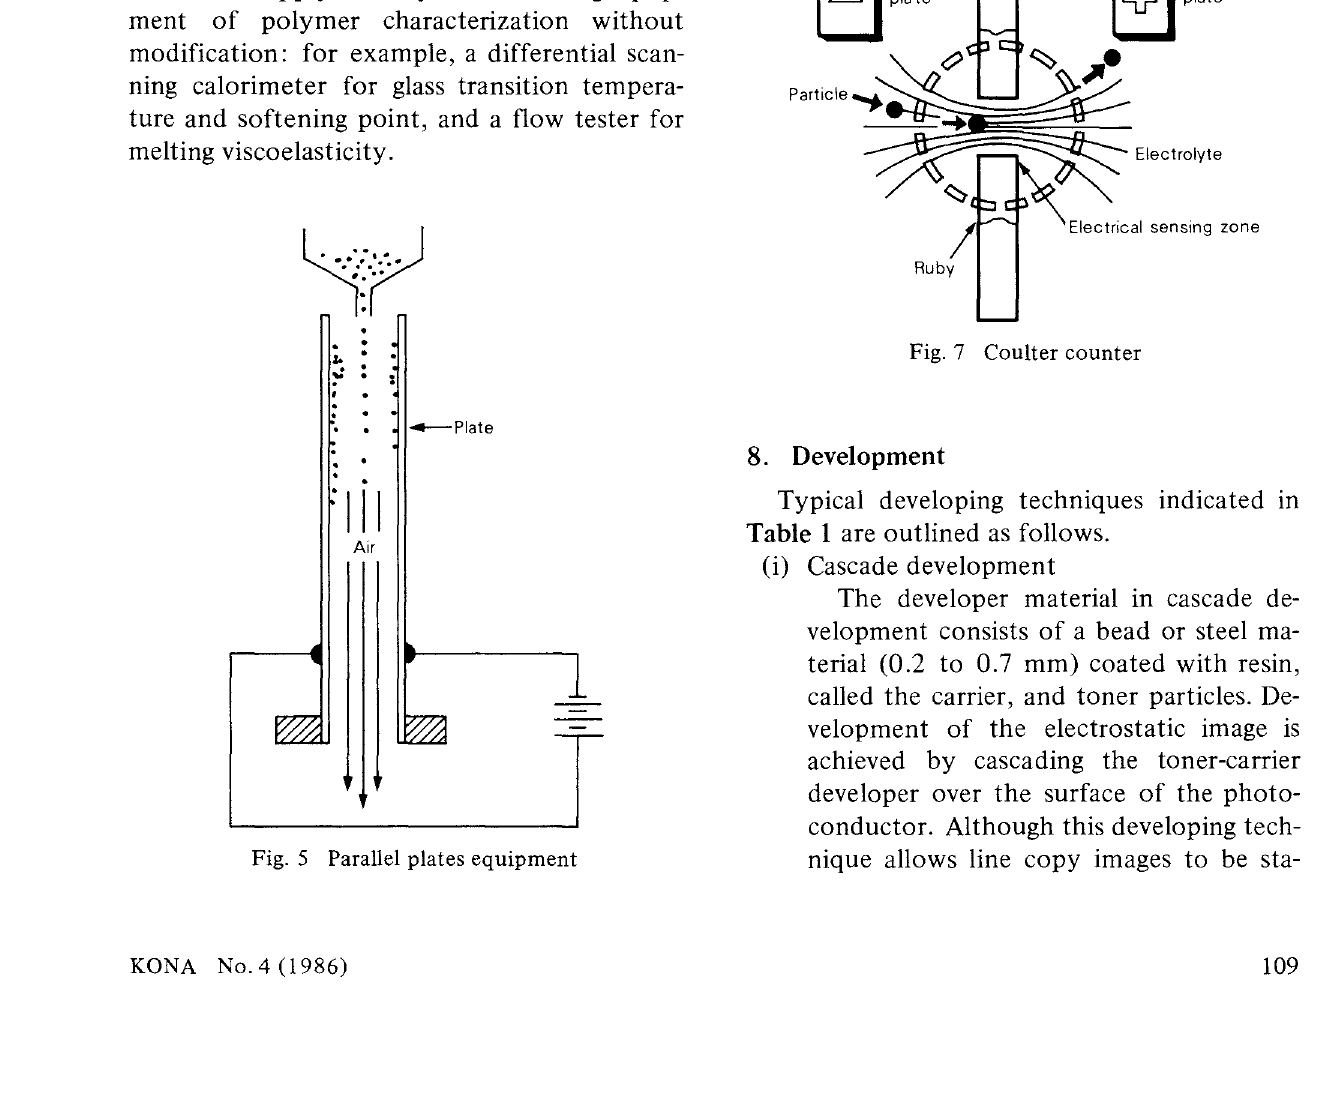
Fig. 6 Charge spectrograph